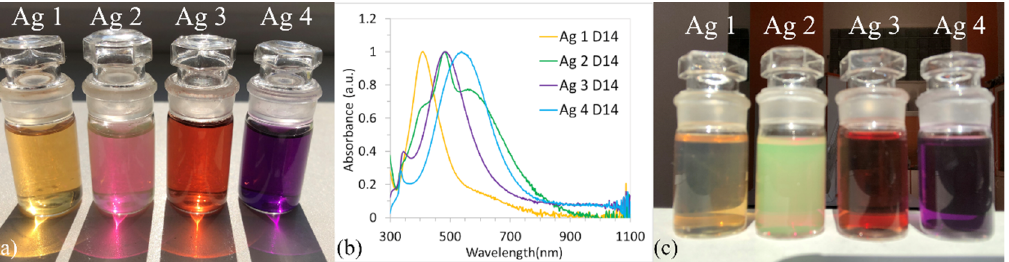
Figure 3. Color of AgNPs colloids on 14th day—view in transmitted light ( a ); absorption spectra of AgNPs colloids on 14th day ( b ); color of AgNPs colloids on 14th day—view in reflected light ( c ).